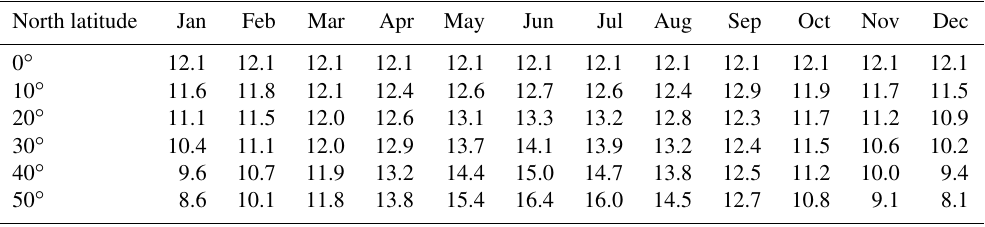
Table B2. Mean monthly values of possible sunshine hours, N . North latitude